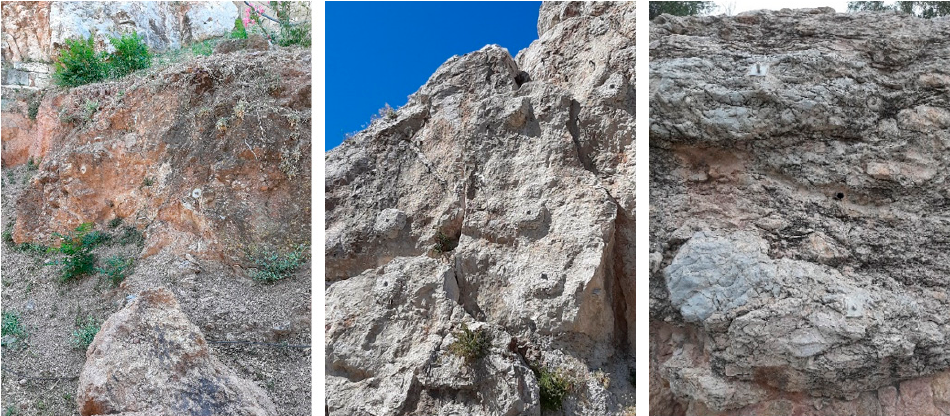
Figure 2. Rock bolts installed for the stabilization of the rockmass in the north and east slope of the Acropolis Hill.